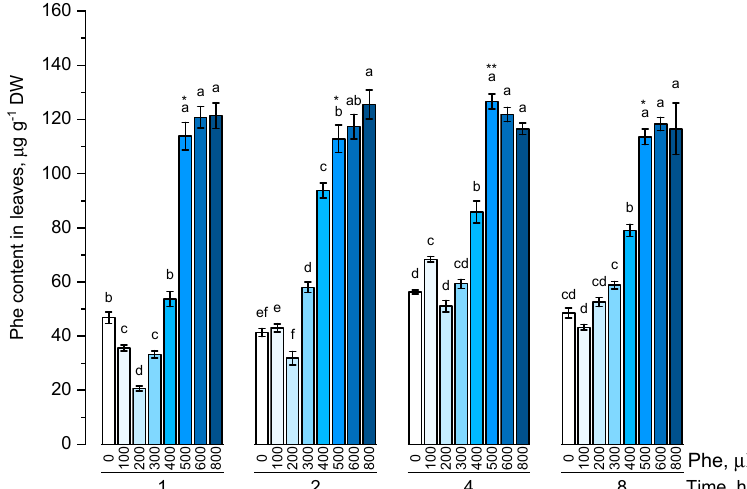
Figure 1. Intracellular content of free phenylalanine in wheat samples incubated on phenylalanine- enriched medium containing various concentrations of the amino acid (100, 200, 300, 400, 500, 600, and 800 μ M) for 1, 2, 4, 8 h. Bars marked with different letters show significant differences for the defined time of cultivation with phenylalanine; asterisk * indicates significant differences among plants exposed for a different time at 500 μ M ( p ≤ 0.05, Tukey’s test).